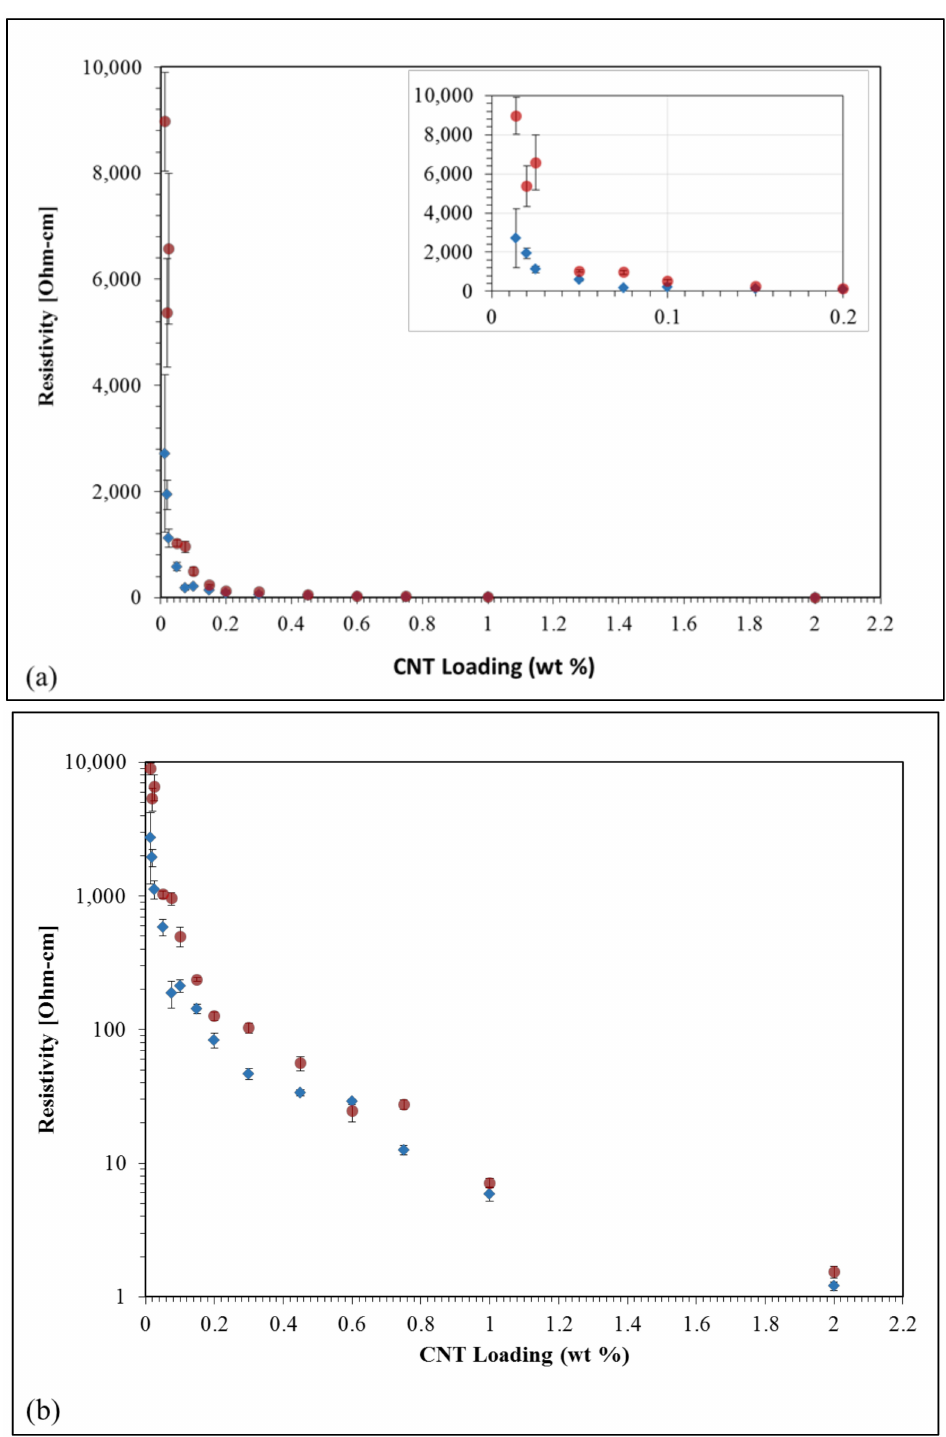
Figure 3. Trends in composite resistivity as function of CNT loading. Blue: lot 1, Red: lot 2. ( a ) Linear scale with inset: Composites at extremely low loading values and ( b ) logarithmic